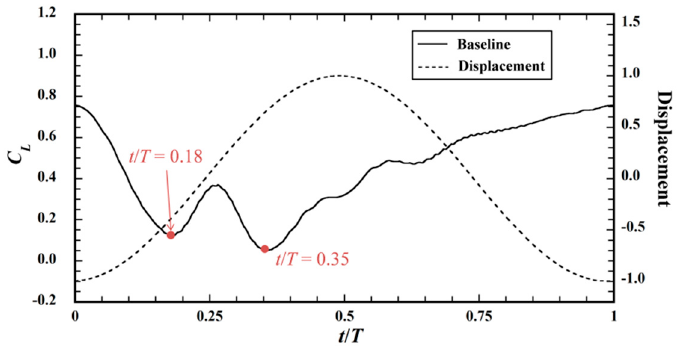
Figure 12. The time fluctuations of lift coefficient in the baseline flow. The dashed line represents the displacement of oscillating plate without the dimension of amplitude.